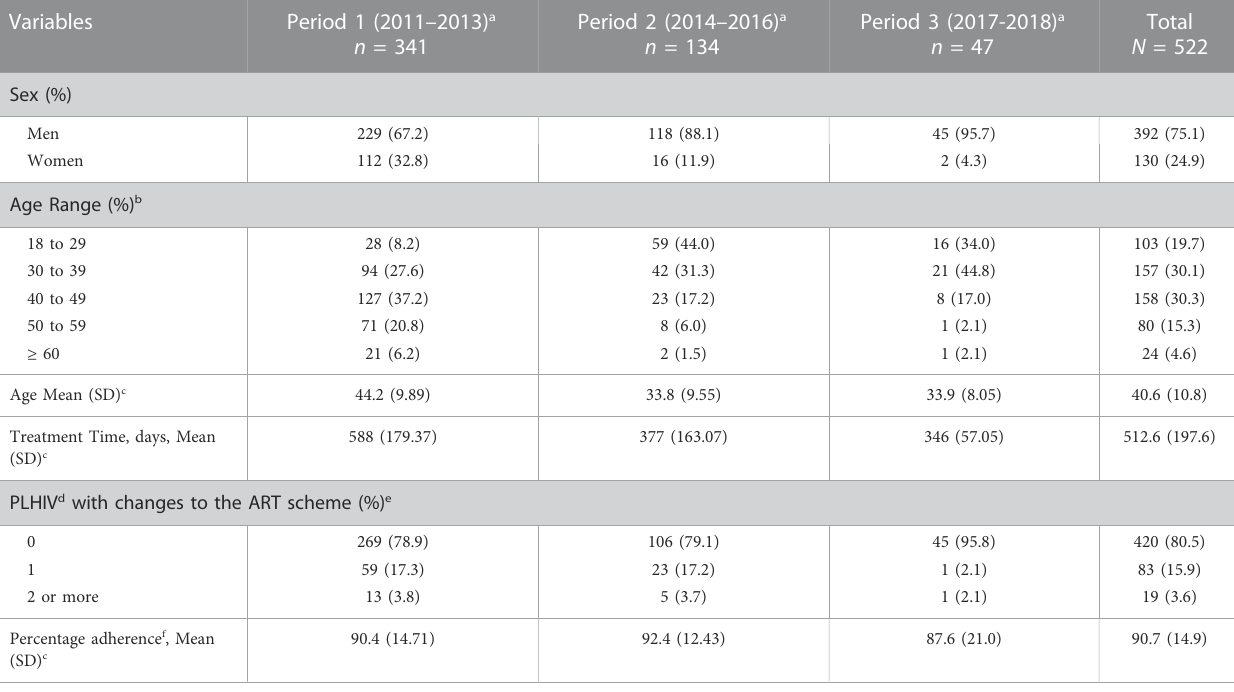
TABLE2SociodemographicandtherapeuticcharacteristicsofpeoplelivingwithHIV/AIDSinthestudyperiods( n =522),HospitalUniversitáriodeBrasilia,Brasilia, Brazil,